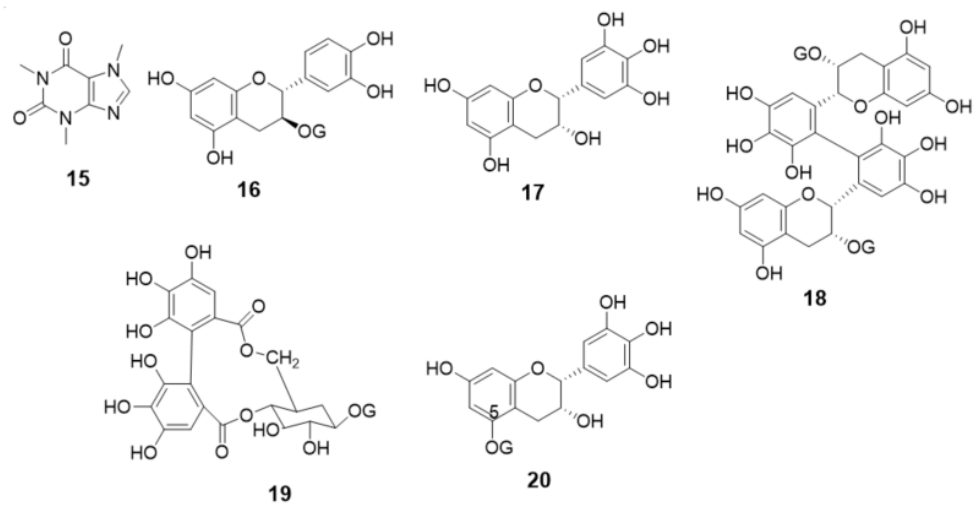
Figure 4. Chemical structures of compounds detected in green tea leaf extract.